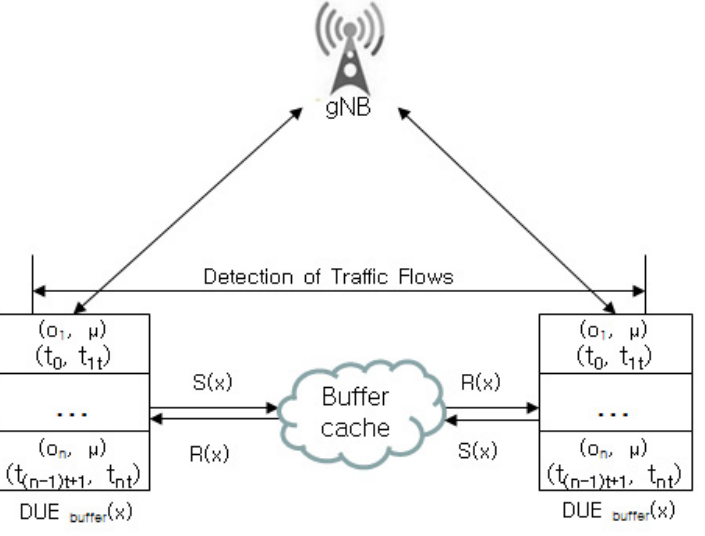
Figure 2. TFRDF structure.